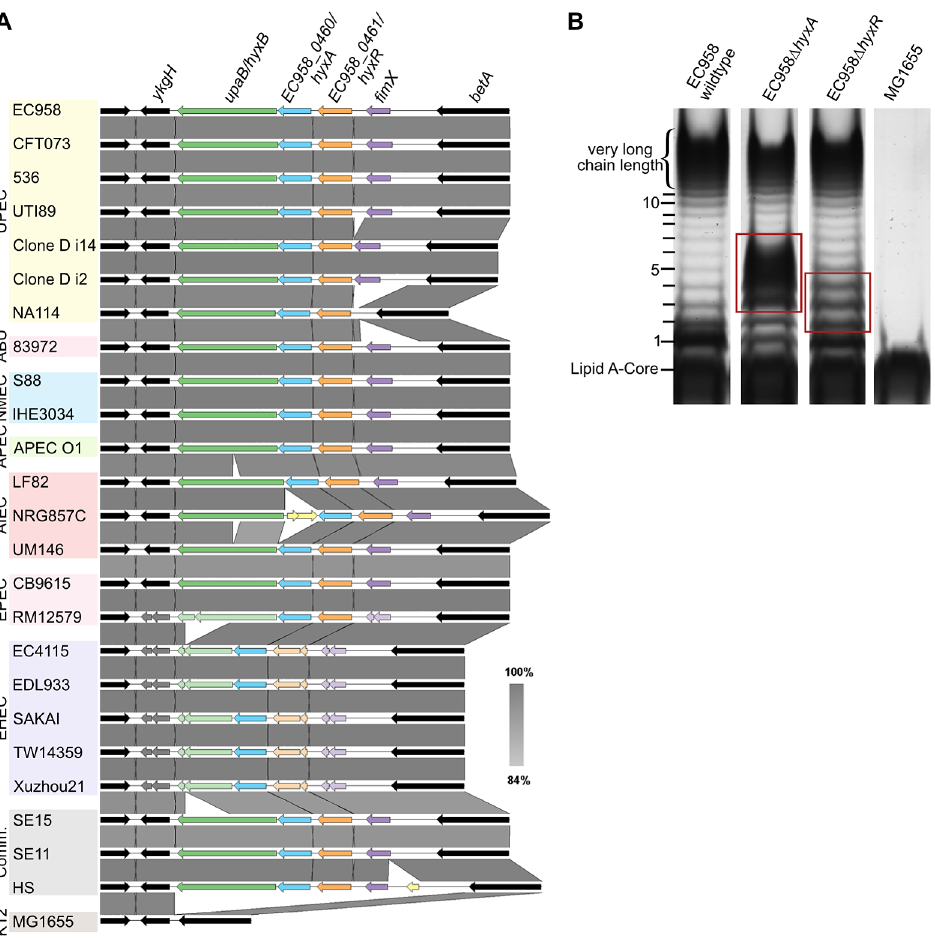
Figure 6. Genetic context of the hyxA and hyxR genes and their role in O-antigen synthesis. (A) The conserved location of PAI-X containing hyxAR genes in E. coli genomes of various pathotypes. (B) The LPS pattern of the hyxA and hyxR mutants and their complemented strains, demonstrating a role for the hyxA and hyxR genes in O-antigen chain length regulation. Red boxes highlight differences in LPS patterns compared with that of the wild-type.